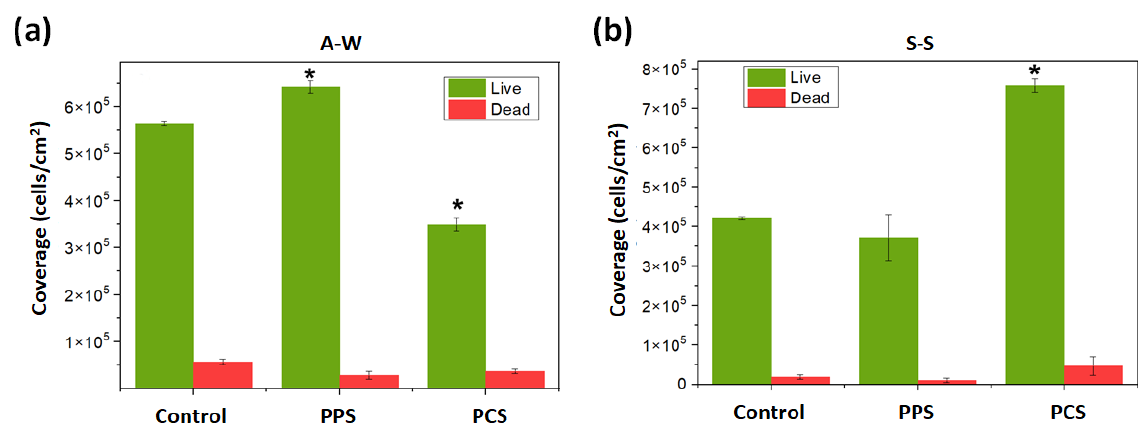
Figure 4. Viability coverage of bacteria with Live/Dead staining during experimental studies. ( a ) A–W period and ( b ) S–S period. Experimental pipelines exposed to pulse-type SMF (PPS), continuous-type (PCS) and control (C) condition. (*) is referred to the significant difference by 95% confidence. The error bars correspond to the standard deviation of the triplicate of each of the samples analyzed.